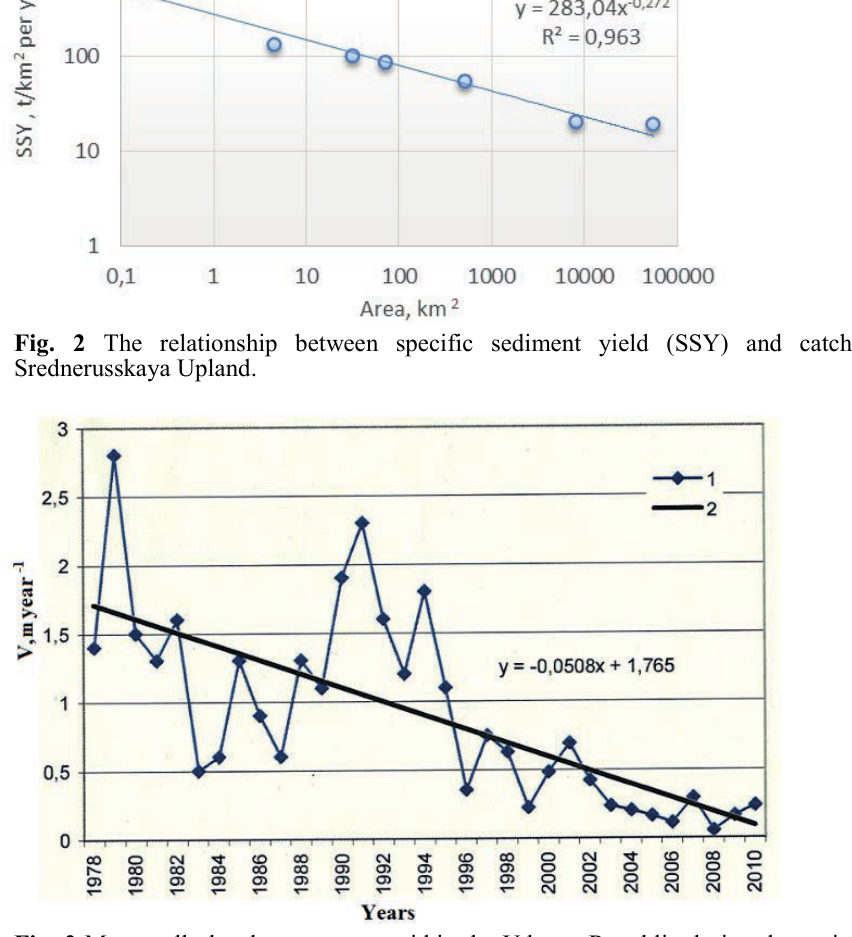
Fig. 3 Mean gully head retreat rates within the Udmurt Republic during the period 1978–2010, based on results of monitoring of 168 gully heads (Rysin & Grigoriev,